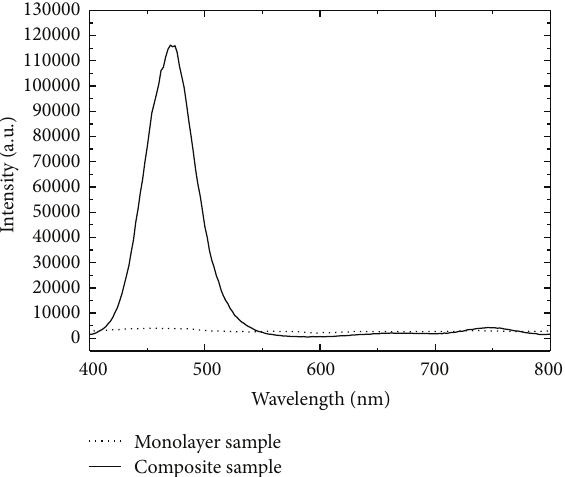
Figure5:Photoluminescenceemissionspectraofcompositesample (straight line) and monolayer sample (dotted line) at 250 nm.